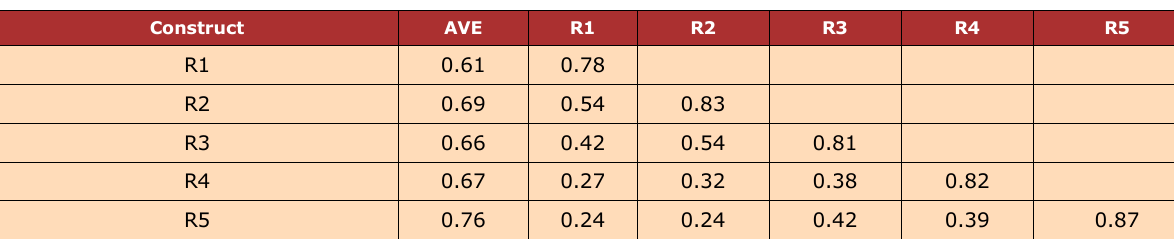
Table 3. AVE and Correlations